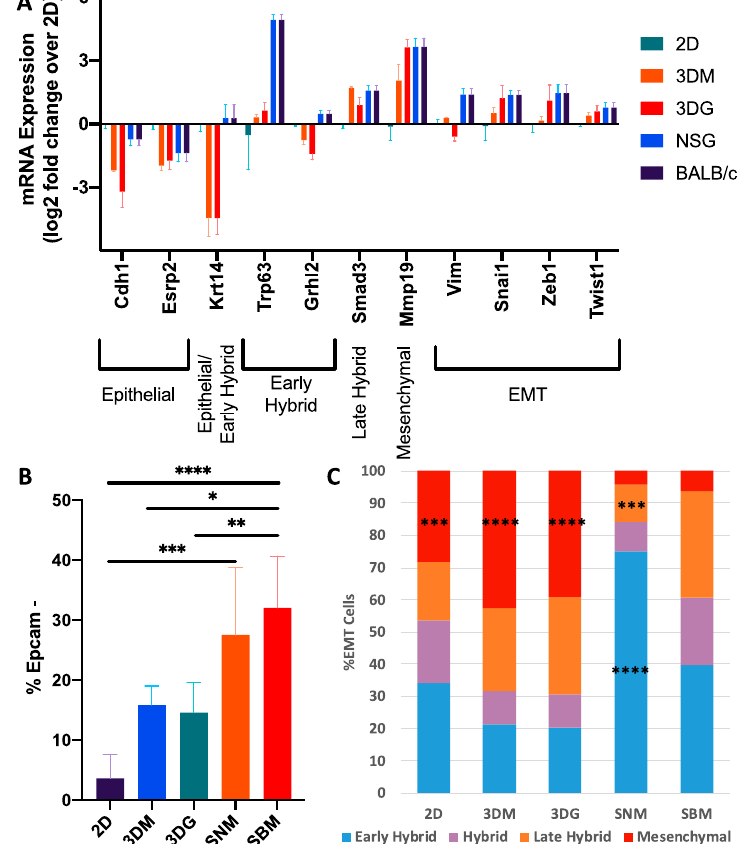
Figure 6. The 4T1 cells in vivo reside in multiple transitional epithelial-to-mesenchymal transition (EMT) states. ( A ) The 4T1 log2 expression of EMT-related genes under different culturing methods relative to 2D culture. Error bars ± SEM. ( B ) Proportion of cells lacking Epcam expression based on flow cytometric analysis (n = 4–7). Error bars ± SD. ( C ) Distribution of EMT cells across hybrid EMT states induced by the culturing method (n = 4–7). * p < 0.05, ** p < 0.0005, *** p < 0.0005, and **** p < 0.0001 relative to SBM.